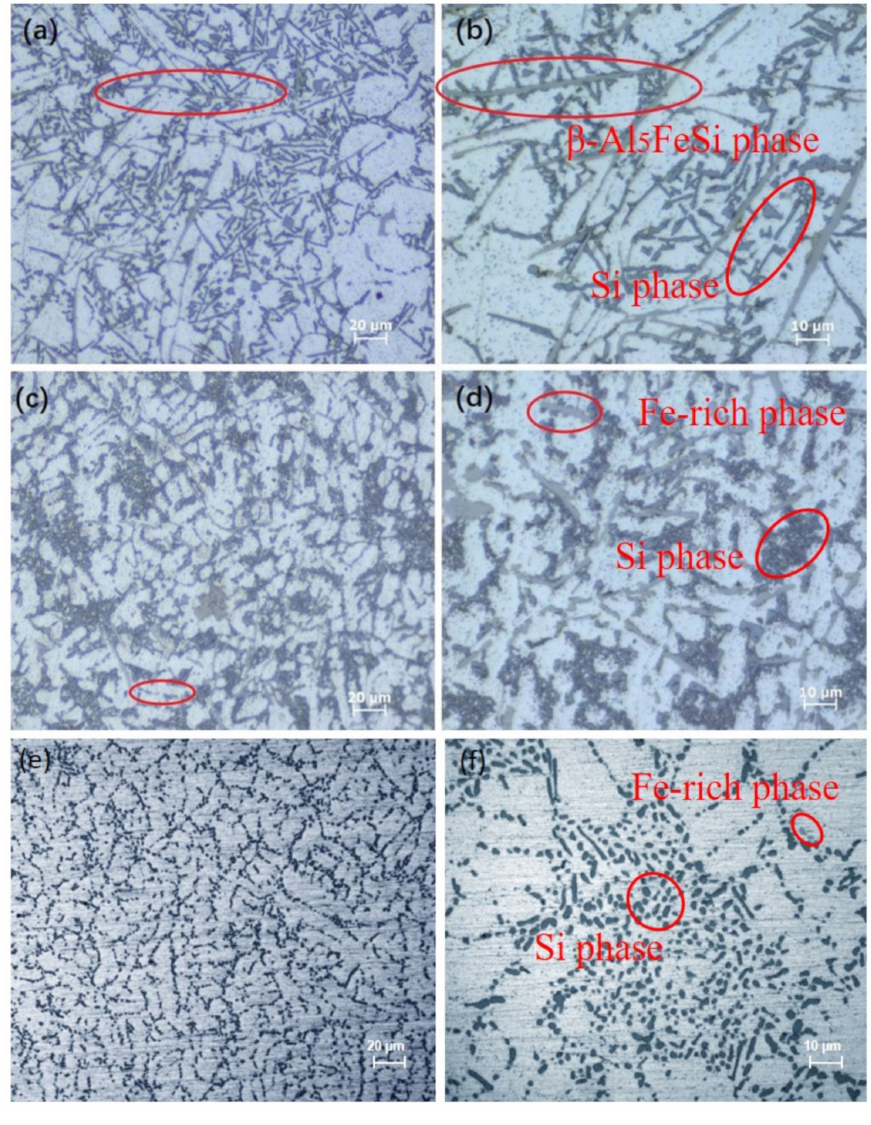
Figure 2. ( a , c , e ) are optical micrographs of C1, C2, and C3 alloy. ( b , d , f ) are optical micrographs showing locally amplified spectra of ( a , c , e ),